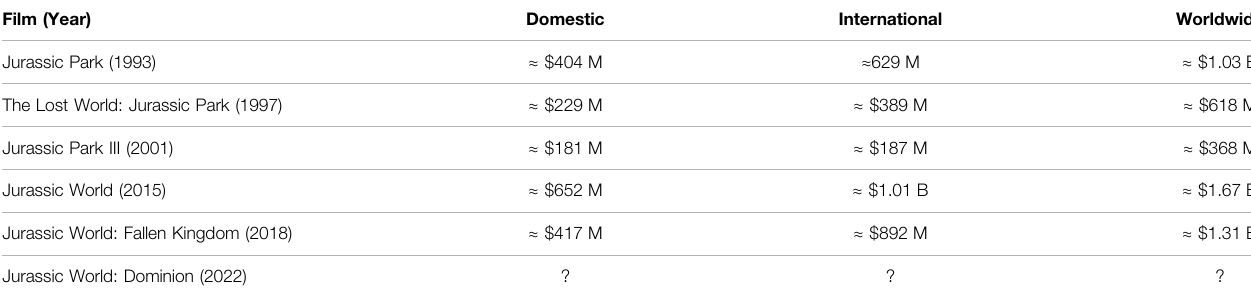
Table Abbreviations: M is million, B is billion in U.S. dollars. All dollar amounts are from data collected by www.boxof fi cemojo.com (as of October 2020).